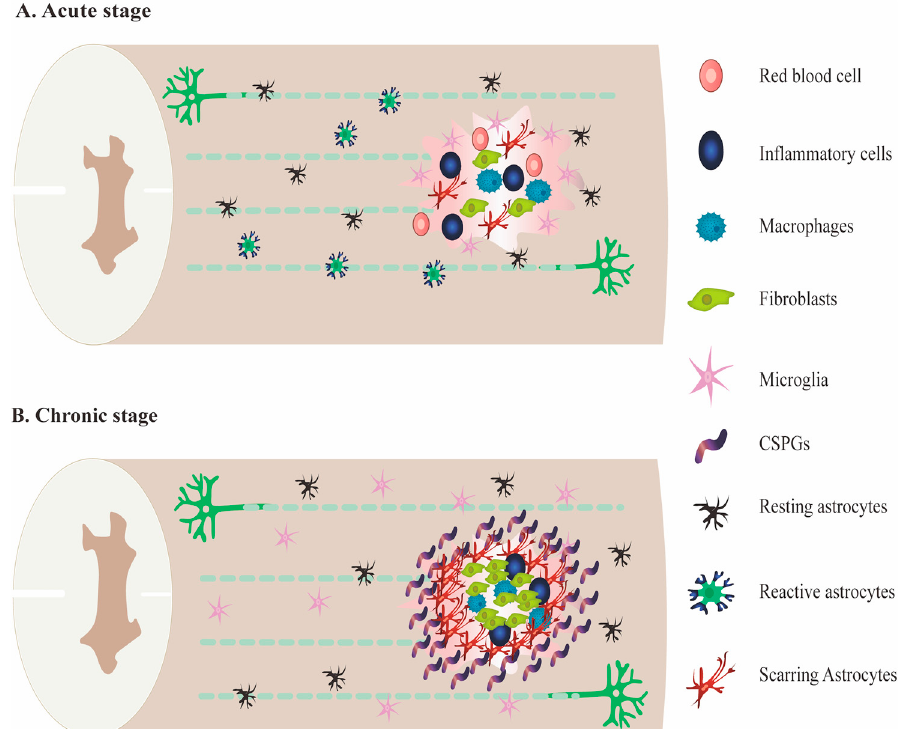
Figure 1. The pathological mechanism in the injury site after SCI. ( A ). Inflammatory cell infiltration and the release of neurotoxins were generated from the inflammatory cascade response of immune cells at the acute stage of SCI, which impeded axonal regeneration in the injury site of SCI. ( B ). Cystic cavities, myelin debris, deposition of GSPGs and astrocytes were progressively generated at the chronic stage of SCI.